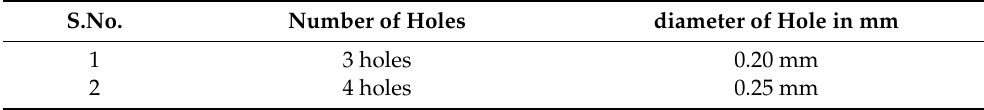
Table 4. Specifications of fuel injectors